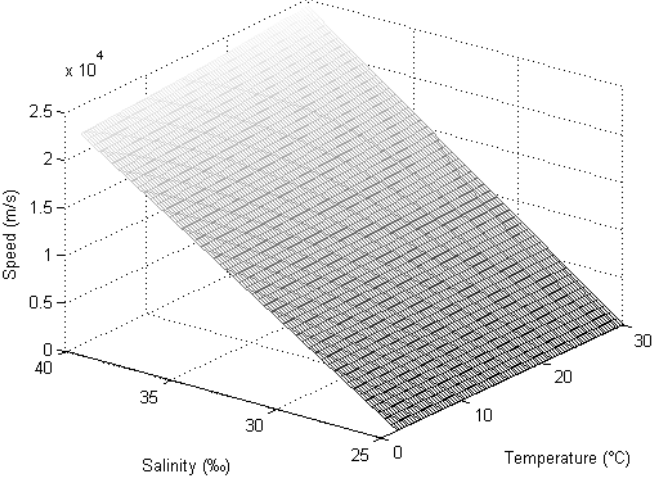
Figure 1. The speed of the acoustic